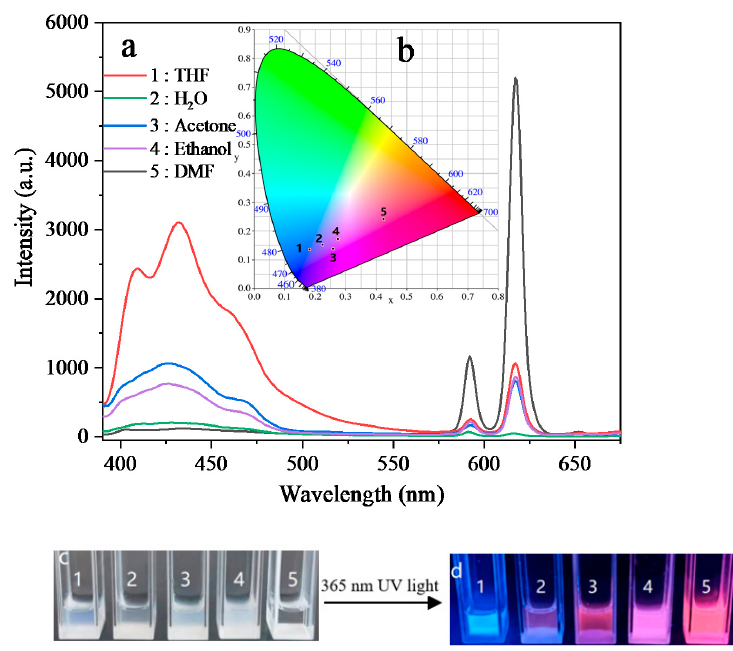
Figure 6. Fluorescence spectra ( a ), the CIE chromaticity diagram ( b ), photographs under visible light ( c ) and 365 nm UV light ( d ) of Eu-PMA-MPEG in different solvents.